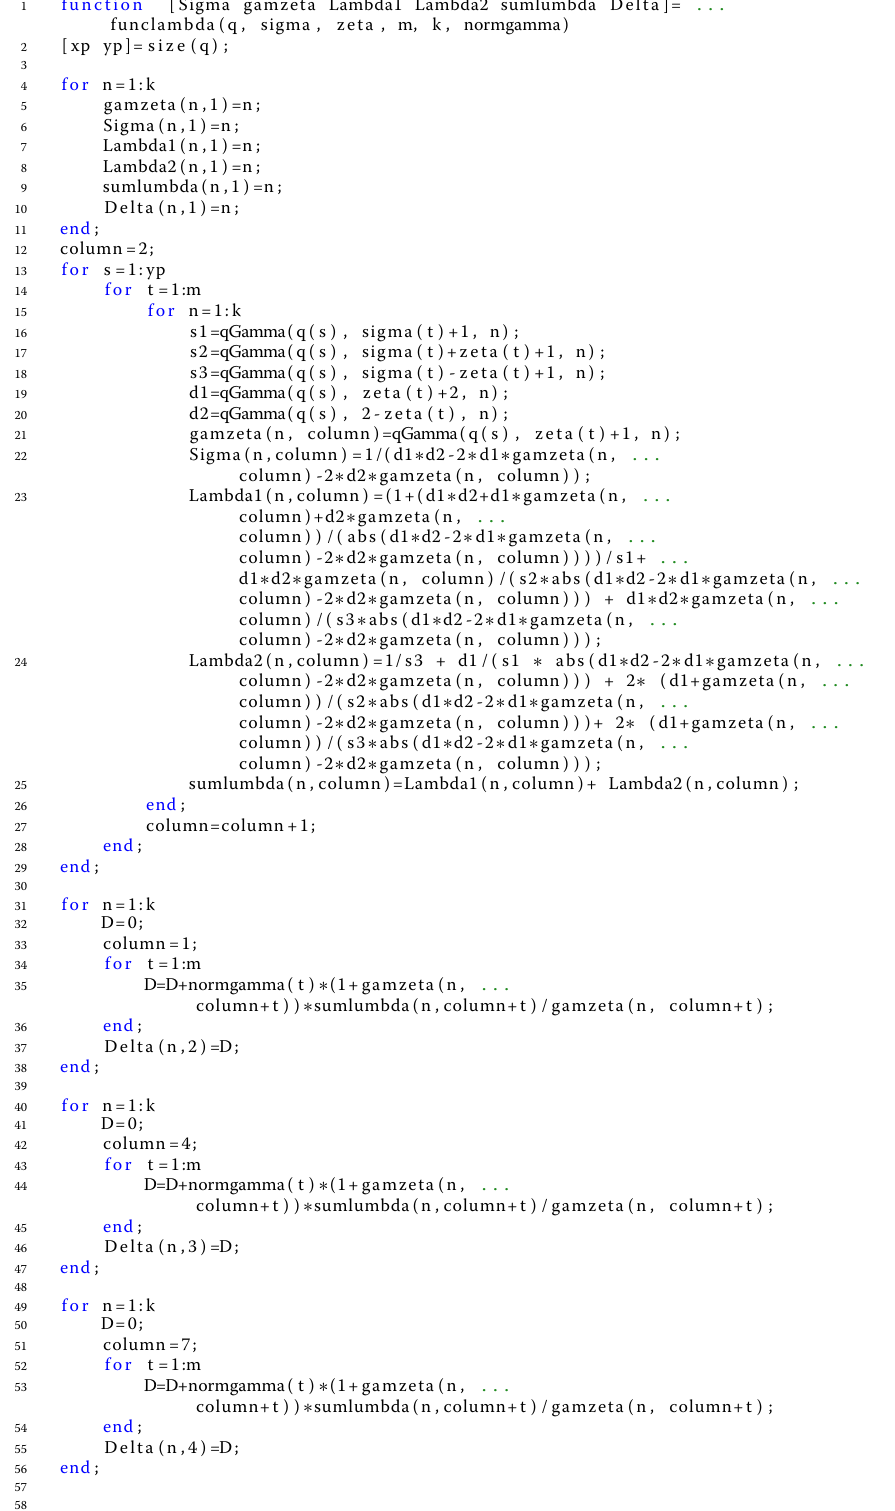
Algorithm 6 The proposed method for calculated Λ 1 i , Λ 2 i , and